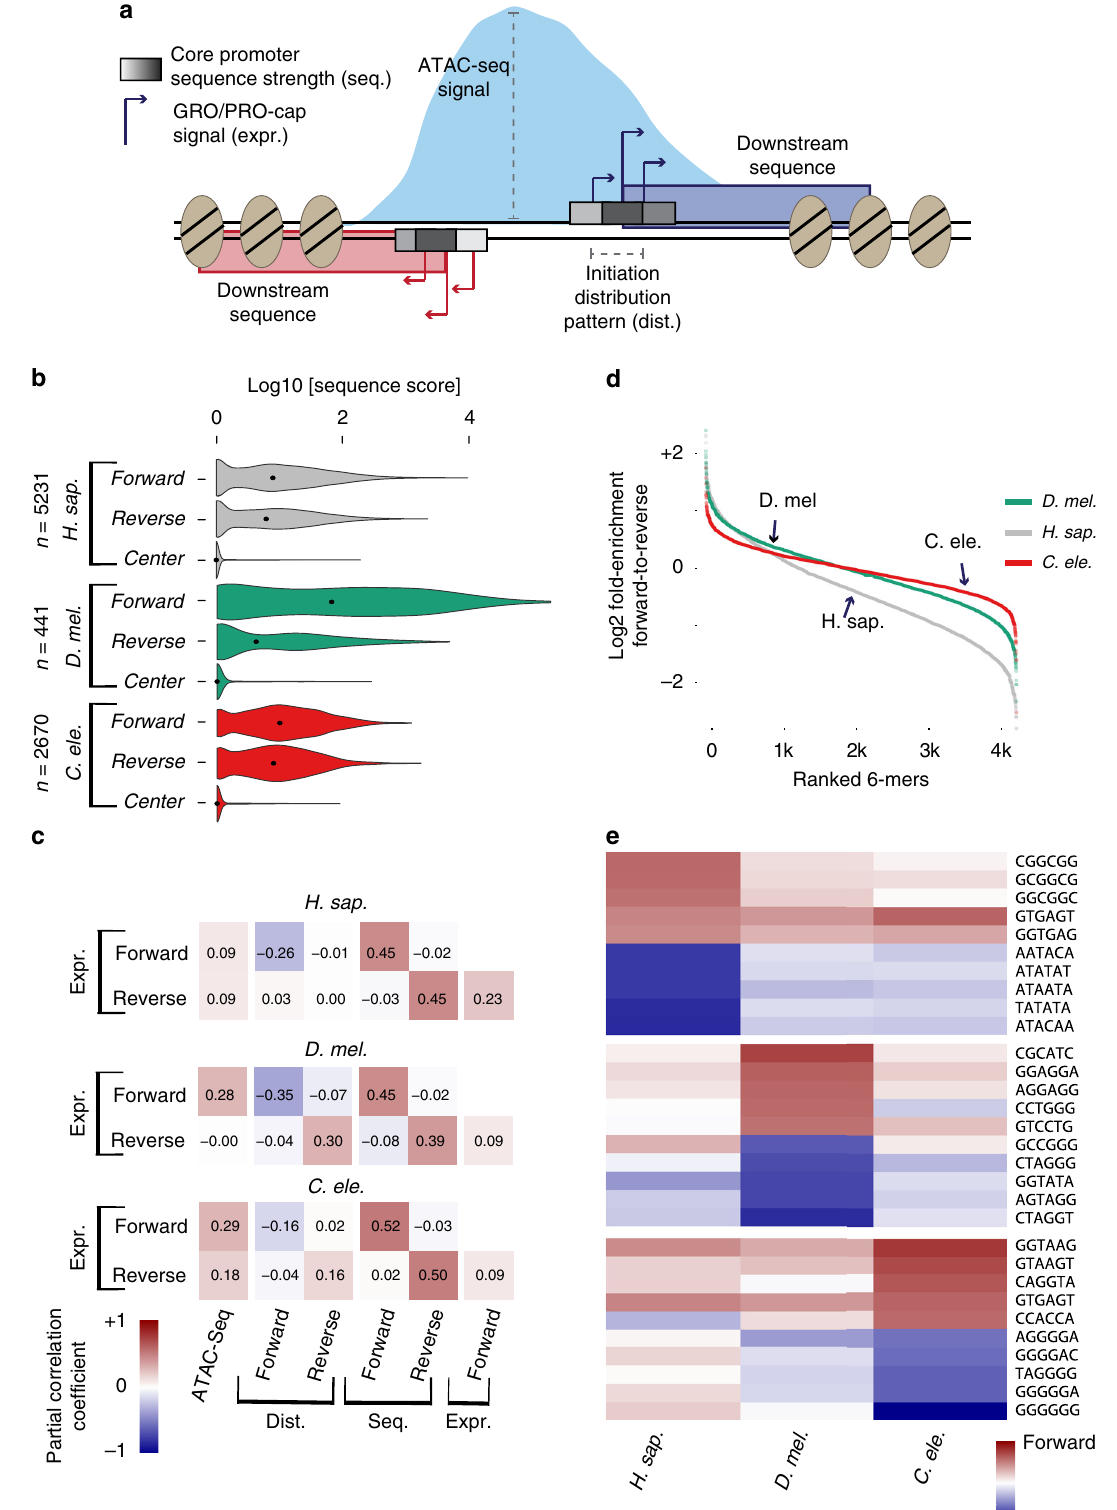
Comparing the 5 most forward- and reverse-enriched sequences of each species shows that these asymmetries are unique to each organism, with the 5 ′ splice site consensus GTGAGT as the only exception (Fig. 2e). For H. sapiens , it con fi rms previous reports of consensus 5 ′ splice site enrichment in the forward direction and